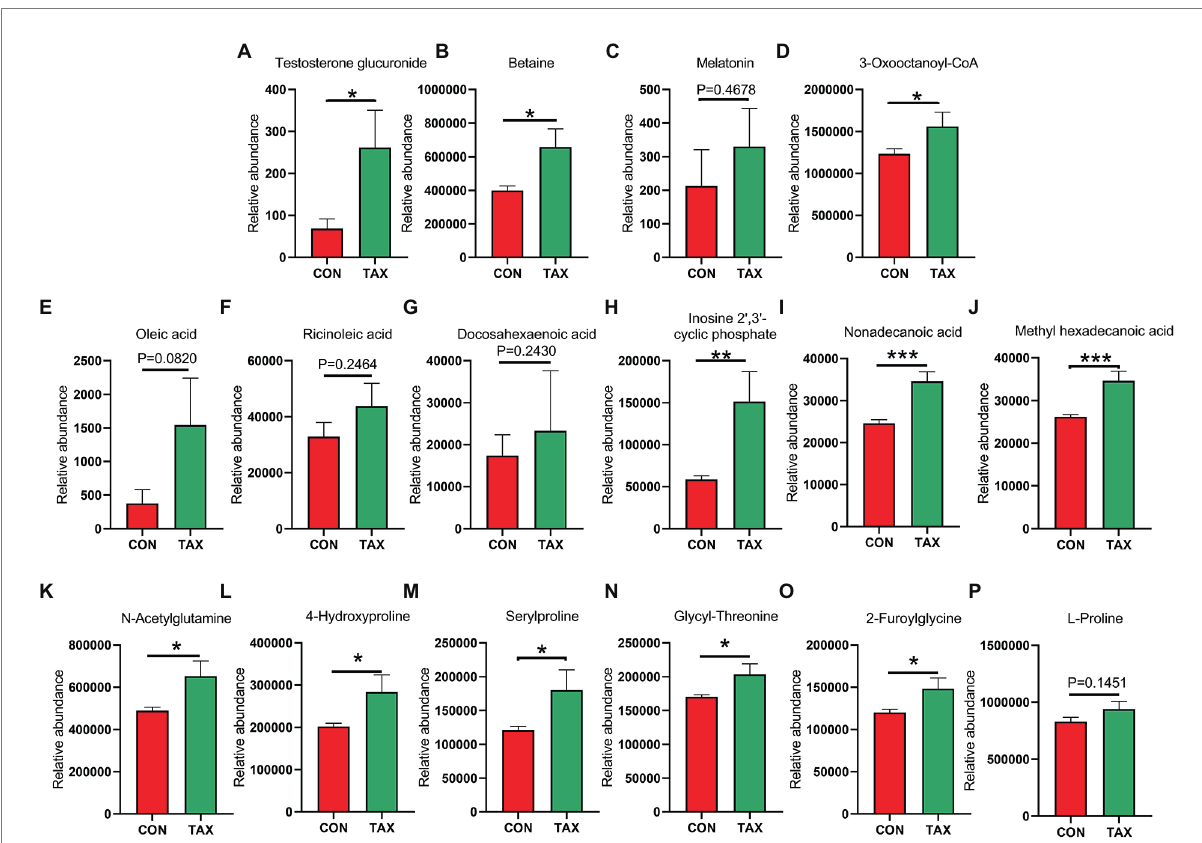
FIGURE 3 TAX increased blood metabolites. (A) Blood testosterone glucuronide level. (B) Blood betaine level. (C) Blood melatonin level. (D) Blood 3-Oxooctanoyl-CoA level. (E) Blood Oleic acid level. (F) Blood Ricinoleic acid level. (G) Blood DHA level. (H) Blood Inosine 2 ′ ,3 ′ -cyclic